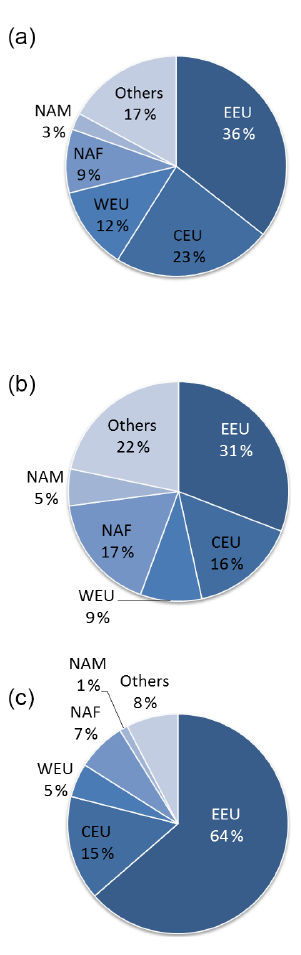
Figure 7. Contribution of each regional footprint density (%) for (a) JJA and (b) DJF in the atmospheric column and (c) JJA in the lowest 2km in the atmosphere. The footprint density of each region is divided by the footprint density of the entire footprint area (EEU + CEU + WEU + NAF + NAM + Others) and then de- scribed in percentage. Information for each region is found in Sect.